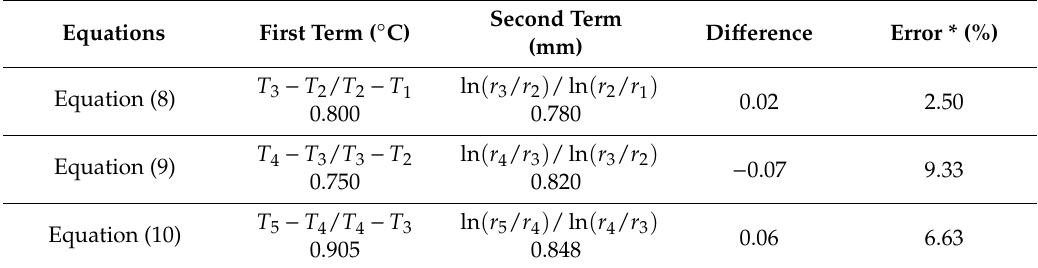
Table 6. Results of each term of Equations (8)–(10), di ff erences, and errors. Equations First Term ( ◦ C)